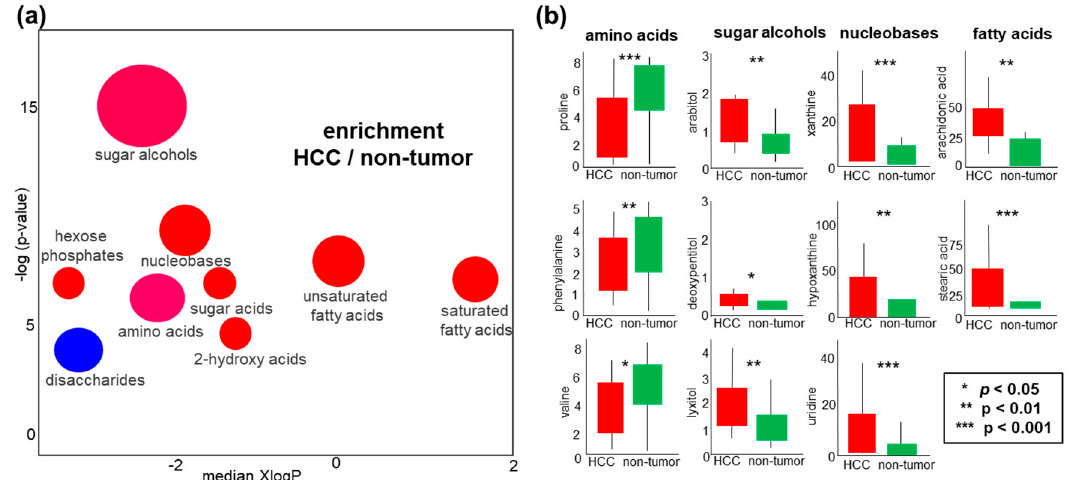
Figure 3. Multivariate analysis of 730 peaks detected by untargeted GC-TOF MS metabolomics analysis of paired HCC tumors versus non-malignant liver tissues. ( a ) sparse Projections to Latent Structures Discriminant Analysis (sPLS-DA). Blue: non-malignant tissues, red: tumor biopsies. Percentages give the total explained variance for vectors 1 and 2. ( b ) Volcano plot for differential regulation of metabolites. Blue: not significant at raw p < 0.05, red: significant changes at p < 0.05.